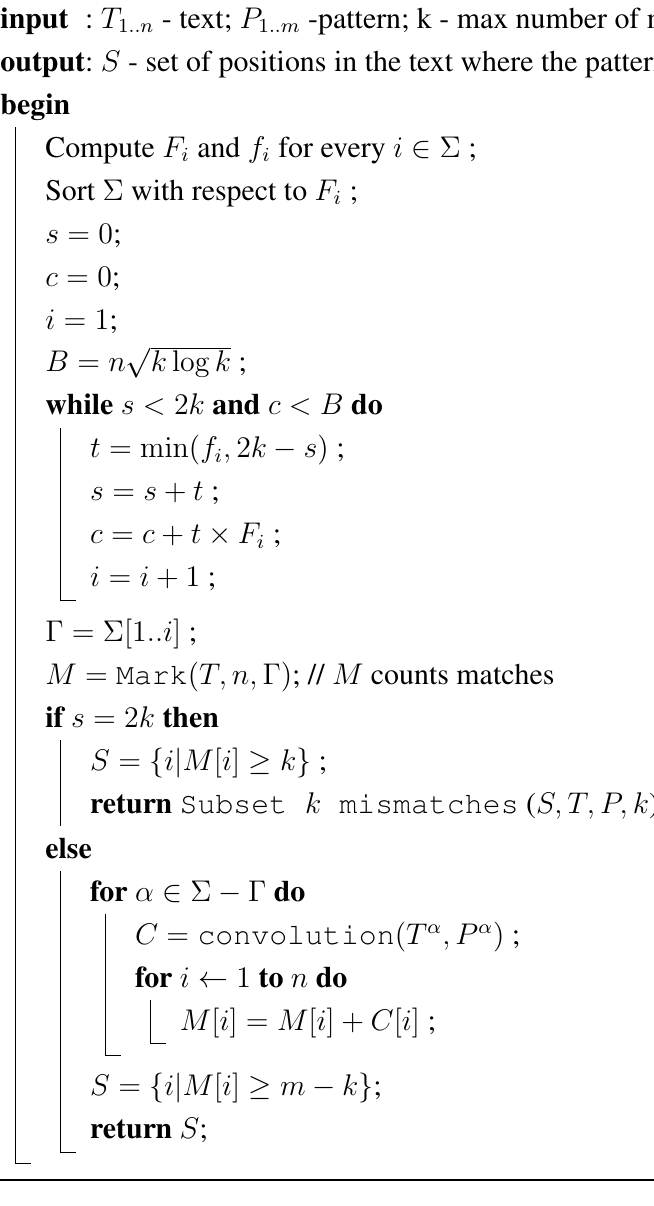
Algorithm 3: Knapsack k mismatches( T, P, k